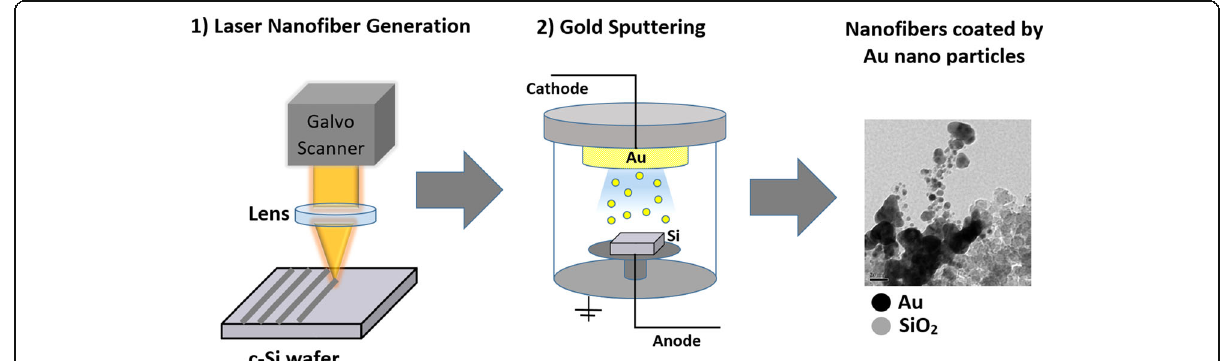
Fig. 1 Approach I: gold sputtering of laser generated silicon oxide nanofibers